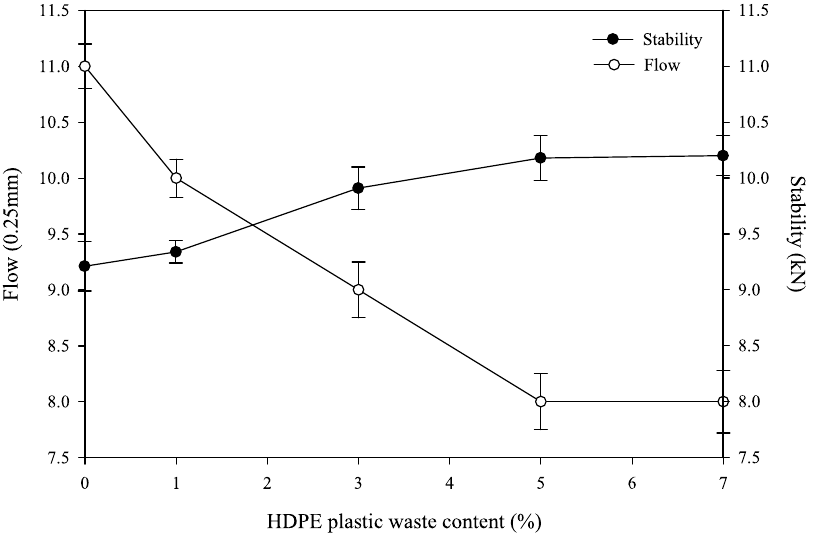
Figure 2. Stability and flow values of HDPE-ACP.